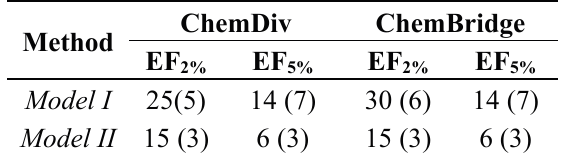
Table 2. EF values at 2% and 5% obtained from pharmacophore searches.